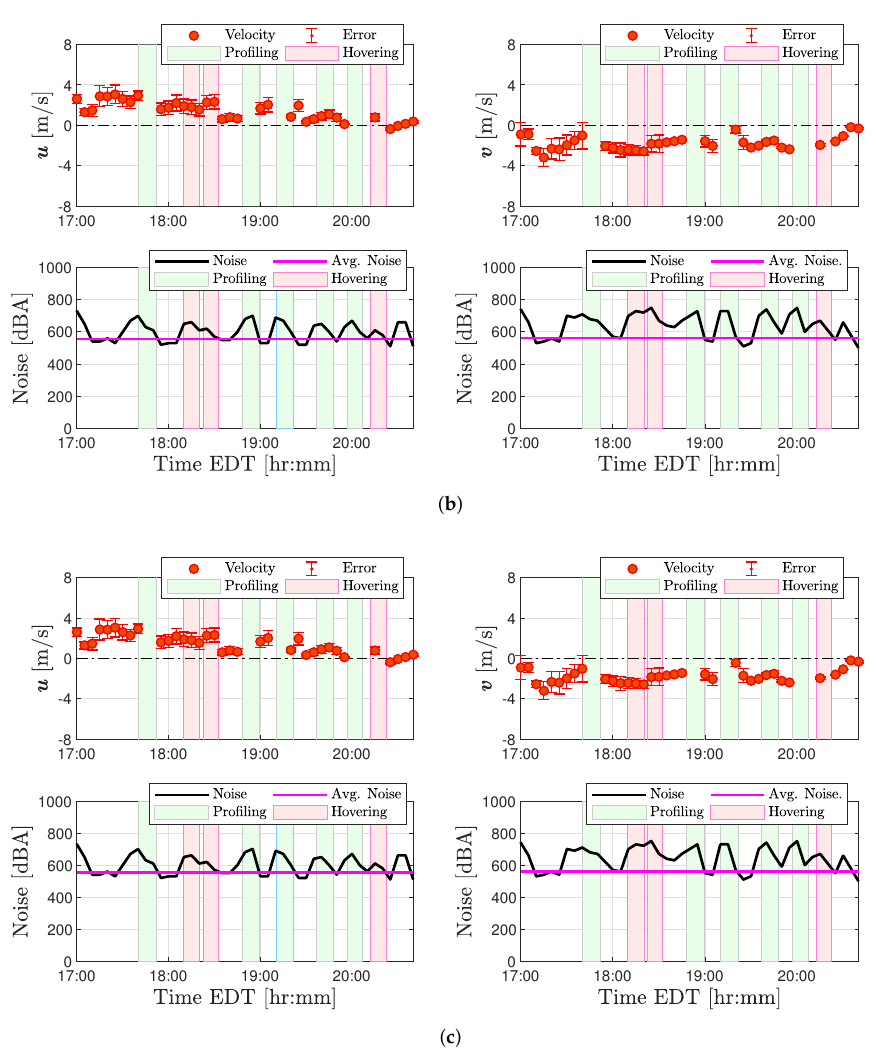
Figure A4. Noise intensity for u and v wind velocity observations from the SR-SoDAR at ( a ) 110 m AGL, ( b ) 70 m AGL, and ( c ) 30 m AGL.